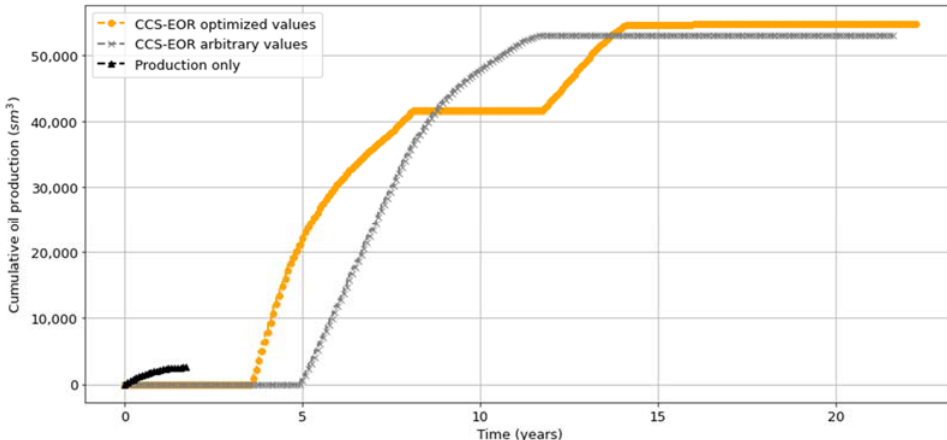
Figure 8. Comparison of cumulative oil production.